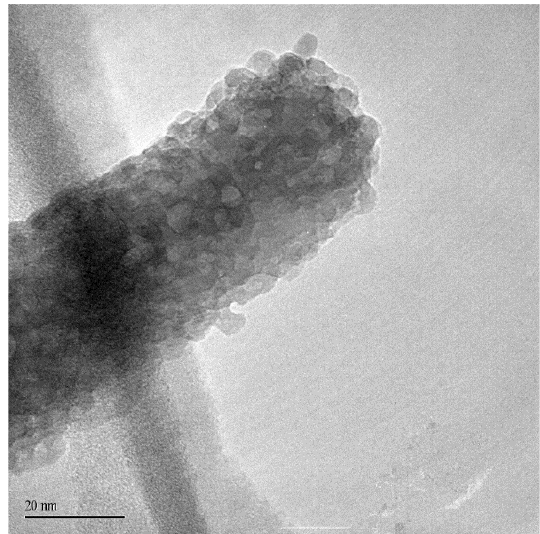
Figure 6. TEM view of an NW from sample A.